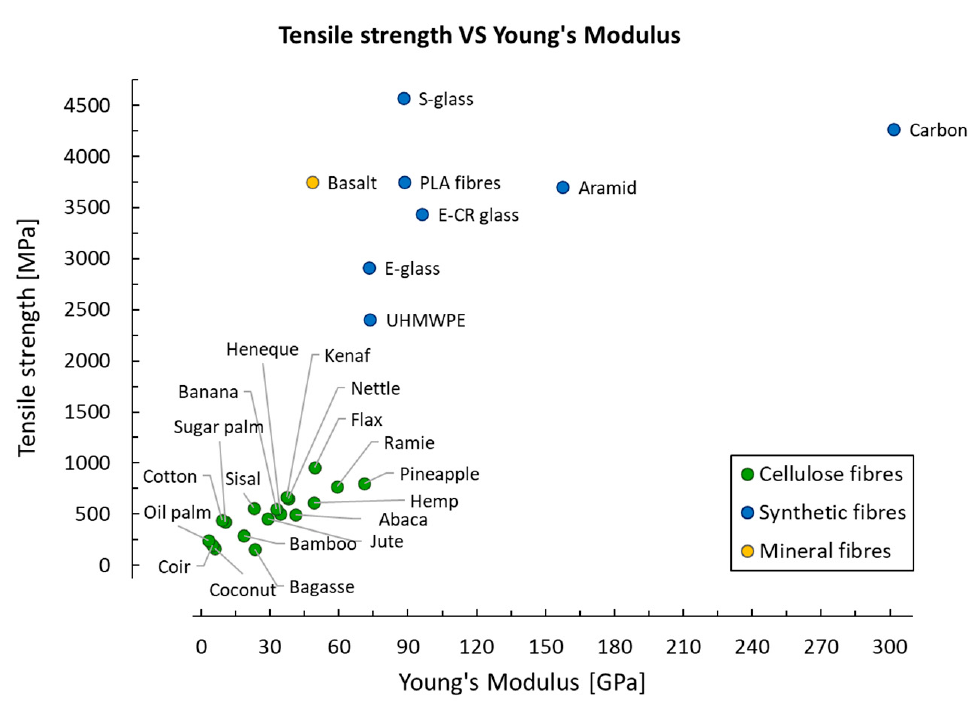
Figure 5. Map of the tensile strength against Young's modulus for several cellulose, synthetic, and mineral fibres. Data from [52, 55, 58-63].